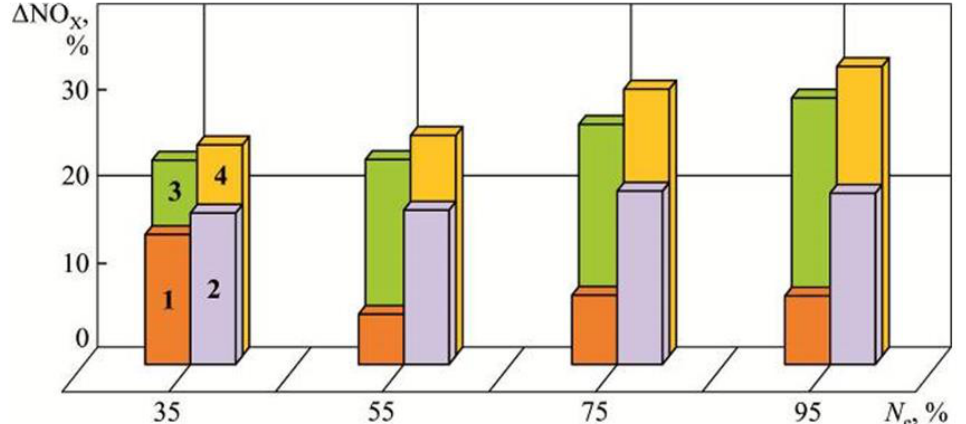
Figure 9. Relative decrease in NO X concentration at different loads of a 16V32 STX-MAN marine diesel engine when using the EGR system: 1— δ EGR = 3%; 2— δ EGR = 9%; 3— δ EGR = 15%; 4— δ EGR =